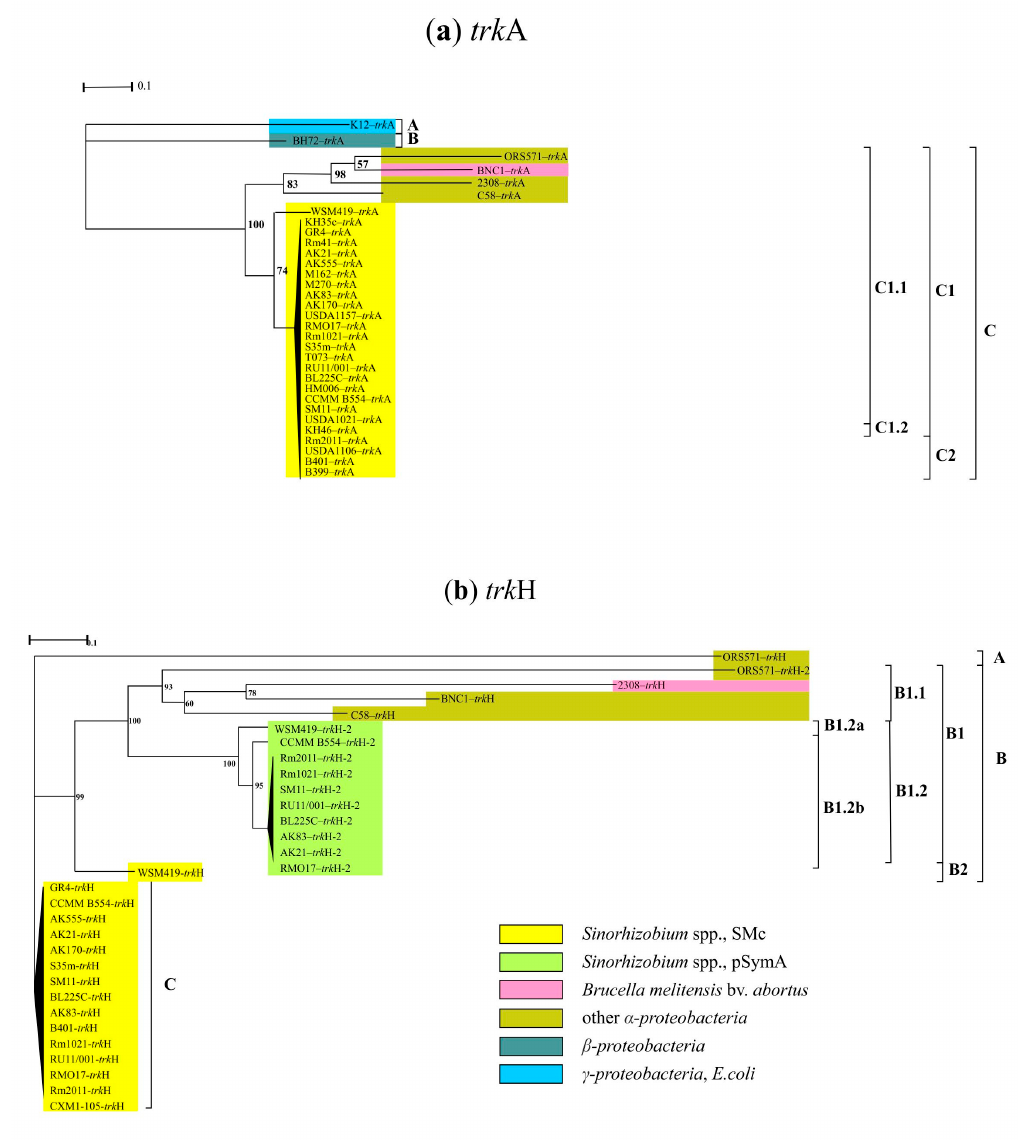
Figure 2. Phylogenetic analysis of trk A ( a ) and trk H ( b ) genes in α -, β - and γ -proteobacteria, as well Actinobacteria . The nucleotide substitution models selected for the analysis were TPM3 + F + G4 for trk A sequences and TIM3 + F + G4 for trk H ones. The scale bars were 0.1 for trk A and trk H nucleotide substitutions per site (see Section 2).